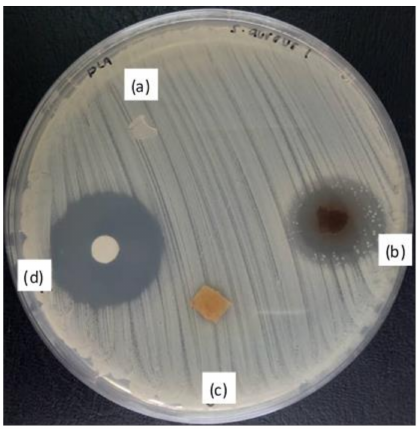
Figure 11. Antimicrobial activity of PLA-based composites against S. aureus after 24 h of incubation at 37 ◦ C for ( a ) PLA-15THY, ( b ) 30JSP-15THY, ( c ) 30BJSP-15THY and ( d ) negative